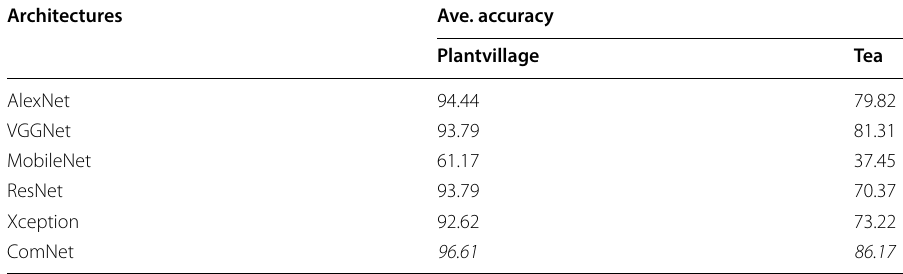
The best performance for each dataset is printed in italics